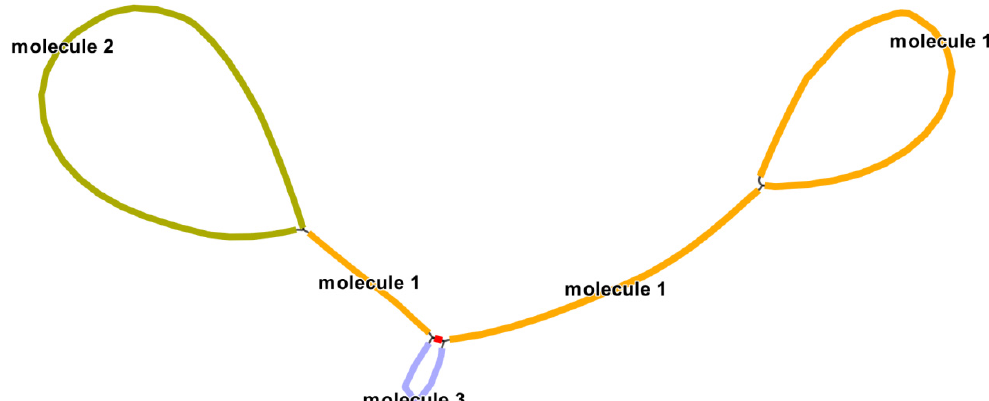
Figure 1. Branched conformation of Q. acutissima mitogenome.